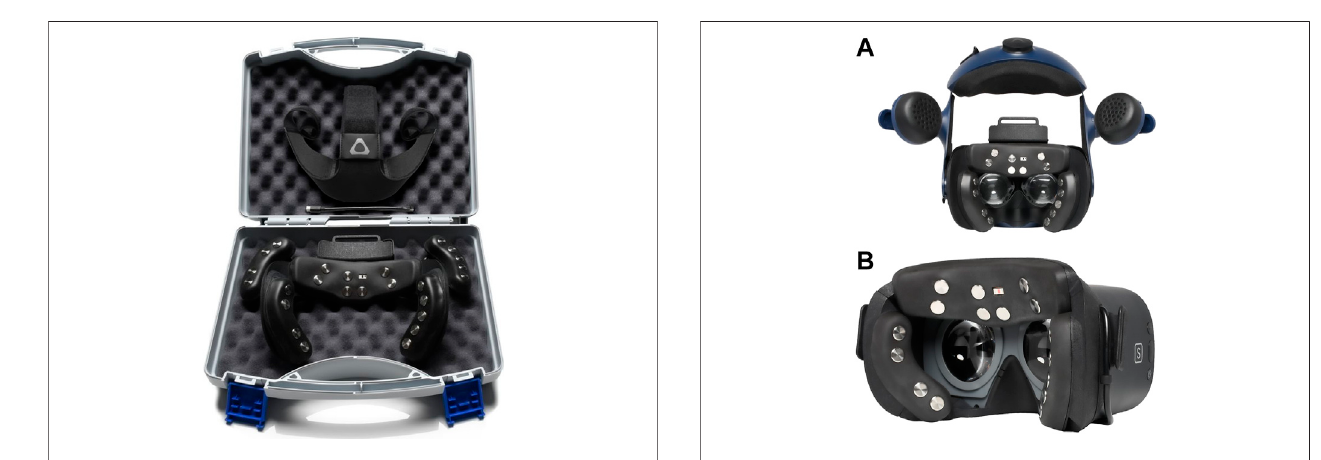
FIGURE 3 | EmteqPRO biosensing insert ($180\times120\times77$mm).